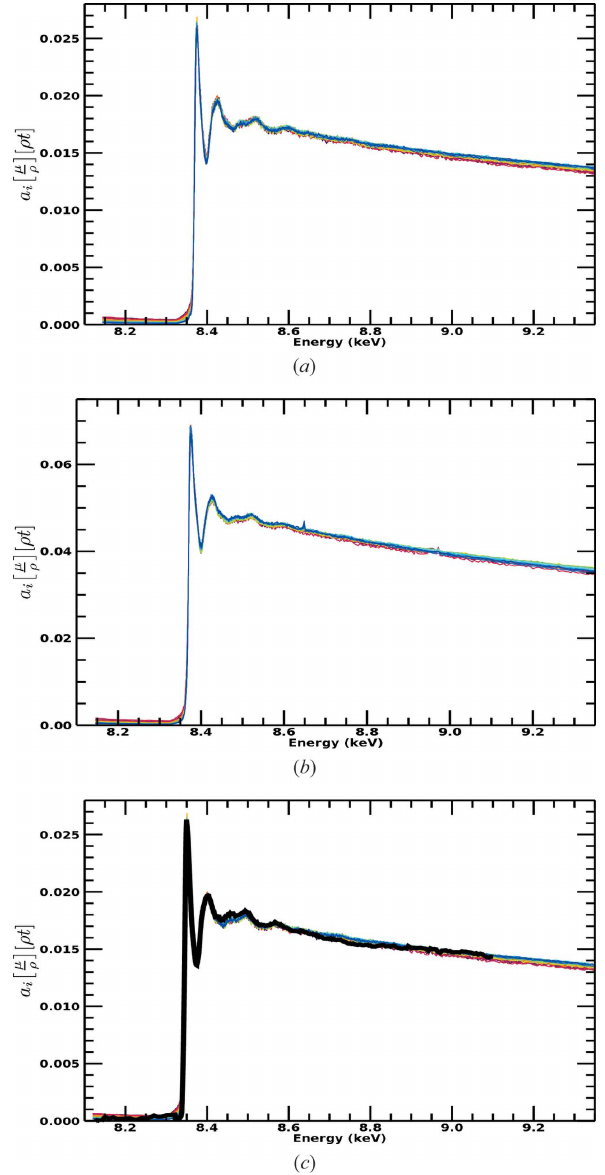
Figure 11 ( a ) Ni i -pr SeAFFluX -corrected spectra. ( b ) Ni n -pr SeAFFluX -corrected spectra. ( c ) Panel ( a ) with a scaled overplot of the transmission XAS spectra. A dramatic reduction in dispersion is observed in the ( SeAFFluX -) corrected spectra. Crucially, the fluorescence spectra (all pixels are plotted) now display the correct decreasing trend at higher energies consistent with the absorption data in Fig. 2, as illustrated in Fig. 11( c ). The fluorescence scale has one free parameter a i corresponding